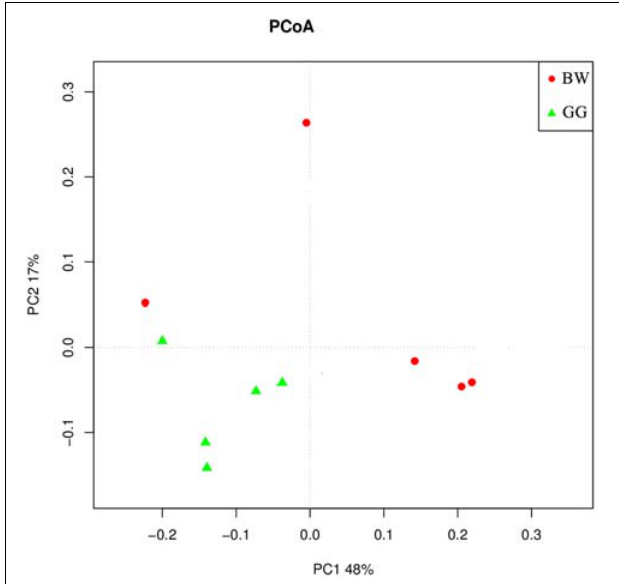
FIGURE 5 | The weighted UniFrac PCoA analysis of the gut microbiota of noble scallops. The GG samples are included in green triangle, and the BW samples are included in red circle. PC1 and PC2 are shown on the x -axis and y -axis, respectively. The percentage of variance explained by each coordinate is